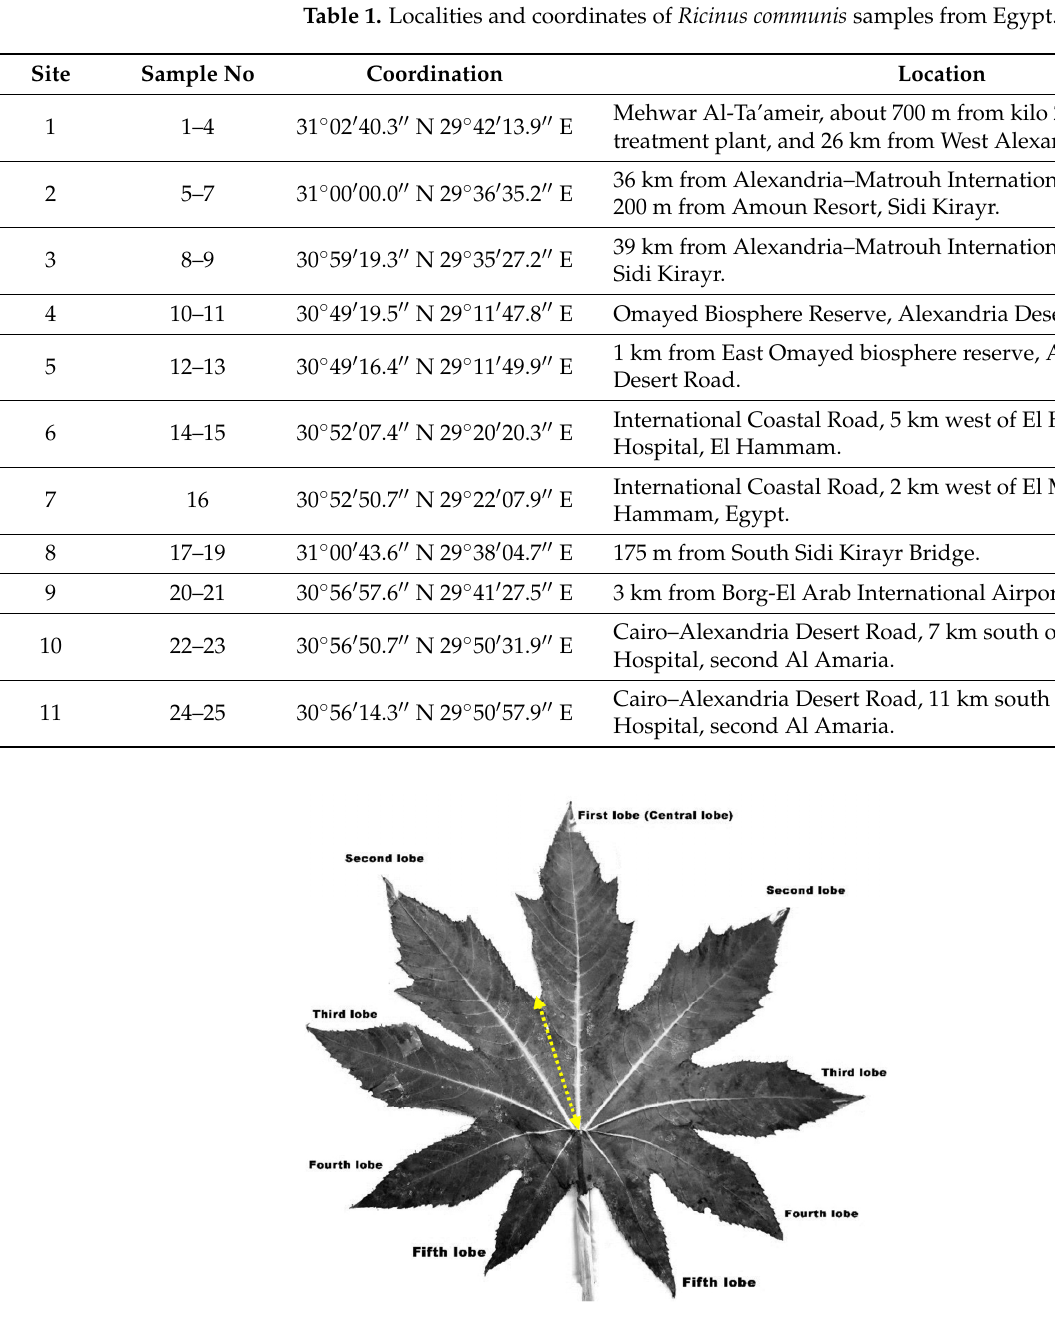
Figure 1. Description of leaf morphological traits in Ricinus communis . The yellow arrow indicates the lobe sinus (depth between two lobes). Table 1. Localities and coordinates of Ricinus communis samples from Egypt.